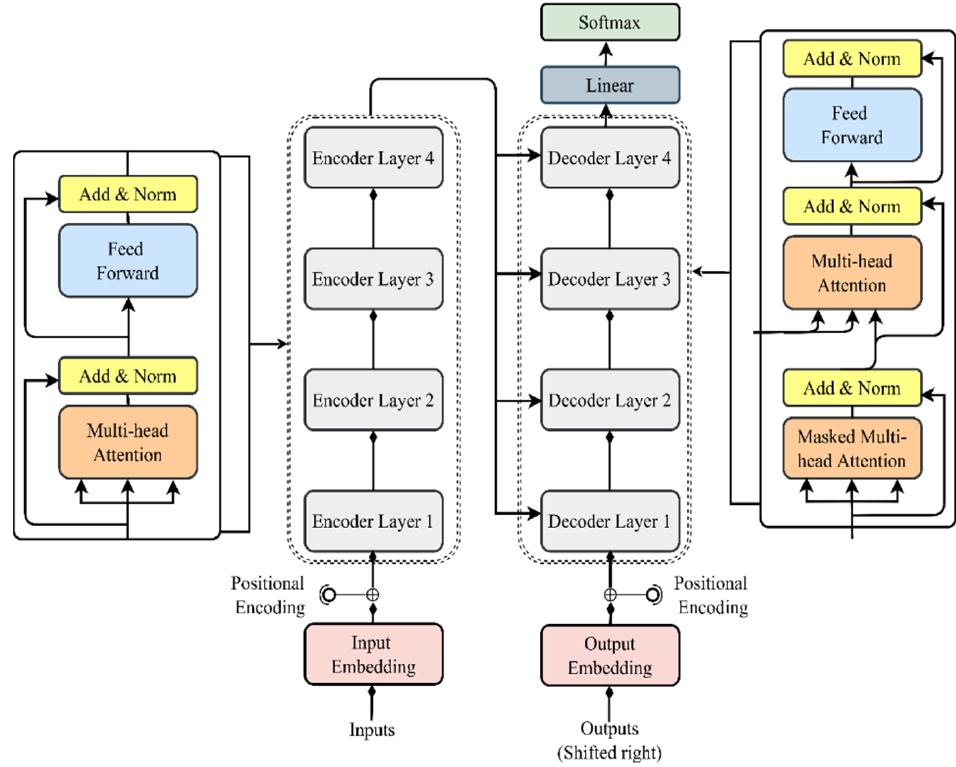
Figure 3. A diagram showing the architecture for the transformer model with four encoder–decoder layers.